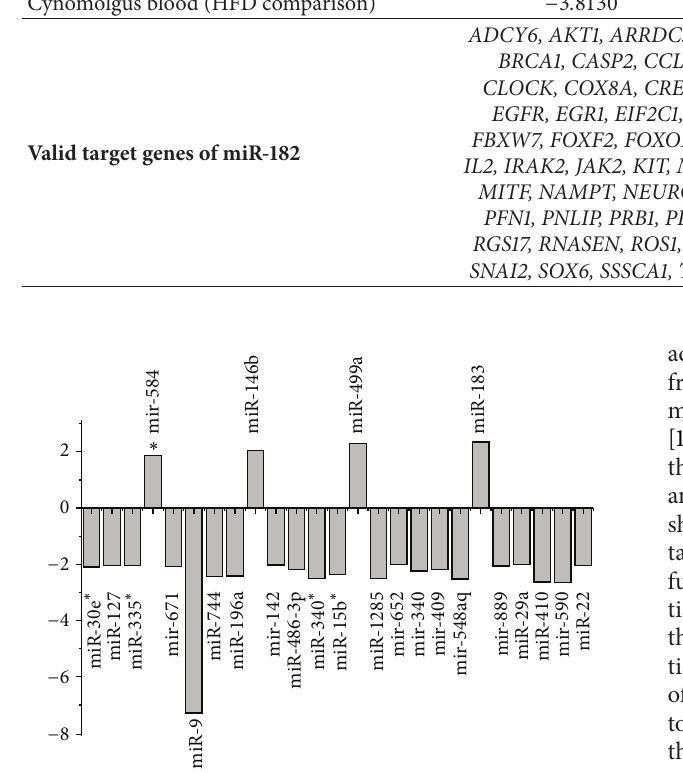
Figure 2: The comparison between the no-T2D individuals in normal diet and HFD. The fold-change of each miRNA in no-T2D comparison was